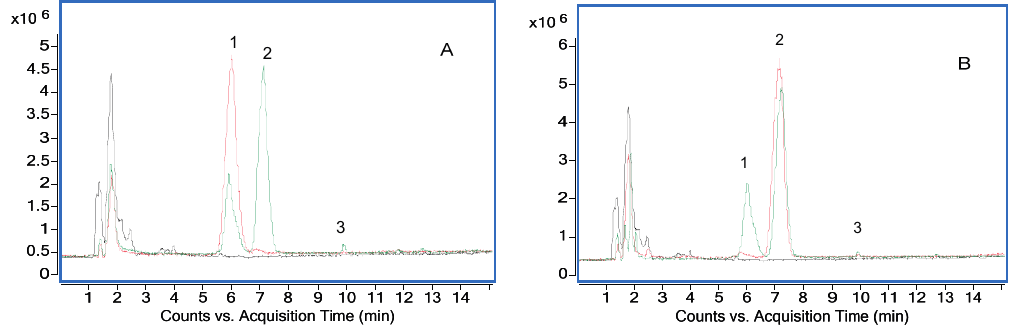
Figure 4. Total ion chromatogram in positive ion mode of the conversion products of rhynchophylline ( A ) and isorhynchophylline ( B ). Reference standards are shown in red, transformation products in green and solvent blank in black.